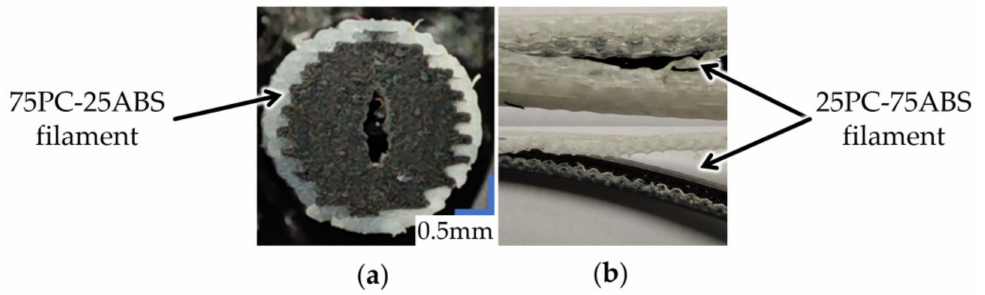
Figure 9. Possible defects of 3D printed filaments. ( a ) Gaps inside the 3D printed filament. ( b ) Shell detach during the